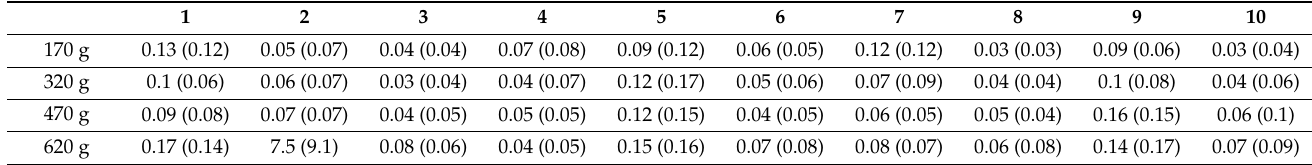
Table 1. Reconstruction error (mean(std)) of four weights from 10 subjects